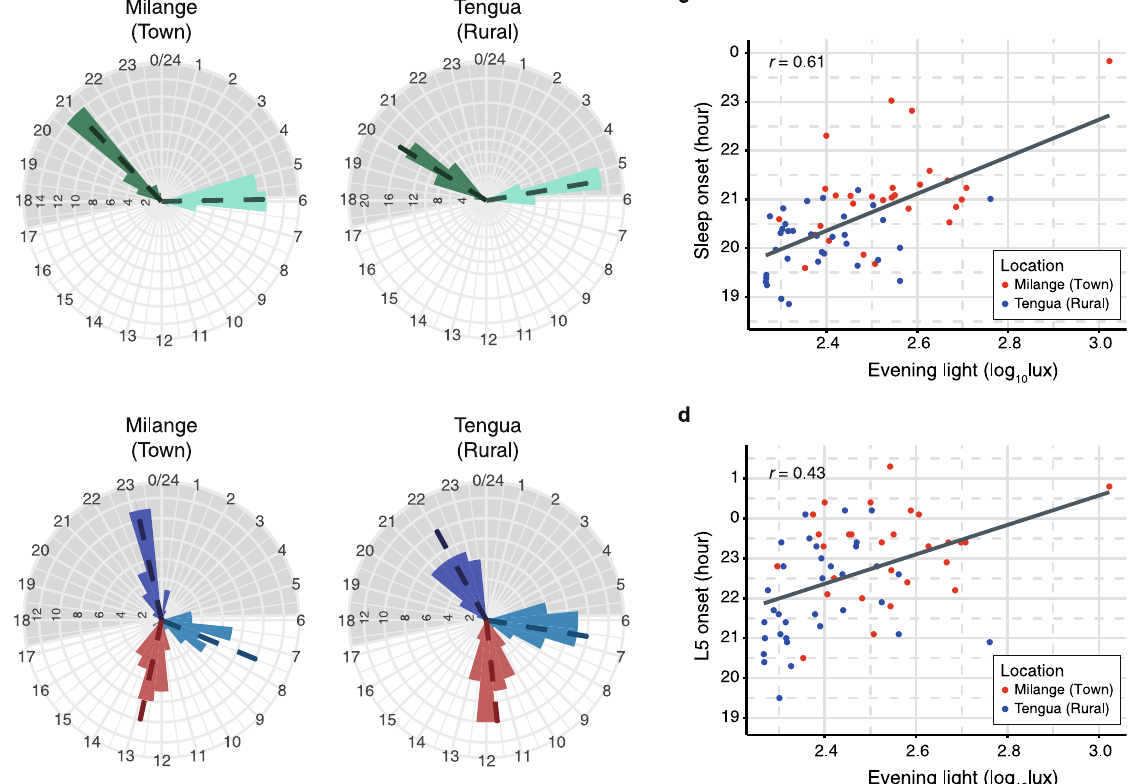
Figure 2. Phase of sleep and activity and amount of evening light exposure. ( a , b ) are circular histograms shown according to clock time where frequencies of temporal activity distributions are shown as distances from the centre. ( a ) Residents of Milange displayed a delayed onset of sleep (green) and a delayed wake up time (light green) compared to residents of Tengua. ( b ) Residents of Milange displayed a delayed M10 activity onset (light blue), a delayed L5 activity onset (purple) and a delayed centre of gravity for activity (red) relative to residents of Tengua. In ( a , b ) means (dotted lines) and histograms with 45 min bins (bars, counts on circumferences) are shown according to 24-h clock time (hours on radii). Grey shading represents average night duration. Sleep onset time ( c ) and L5 onset time ( d ) correlated with total exposure to light after sunset. Evening light exposure is distributed by location (Milange, red; Tengua,